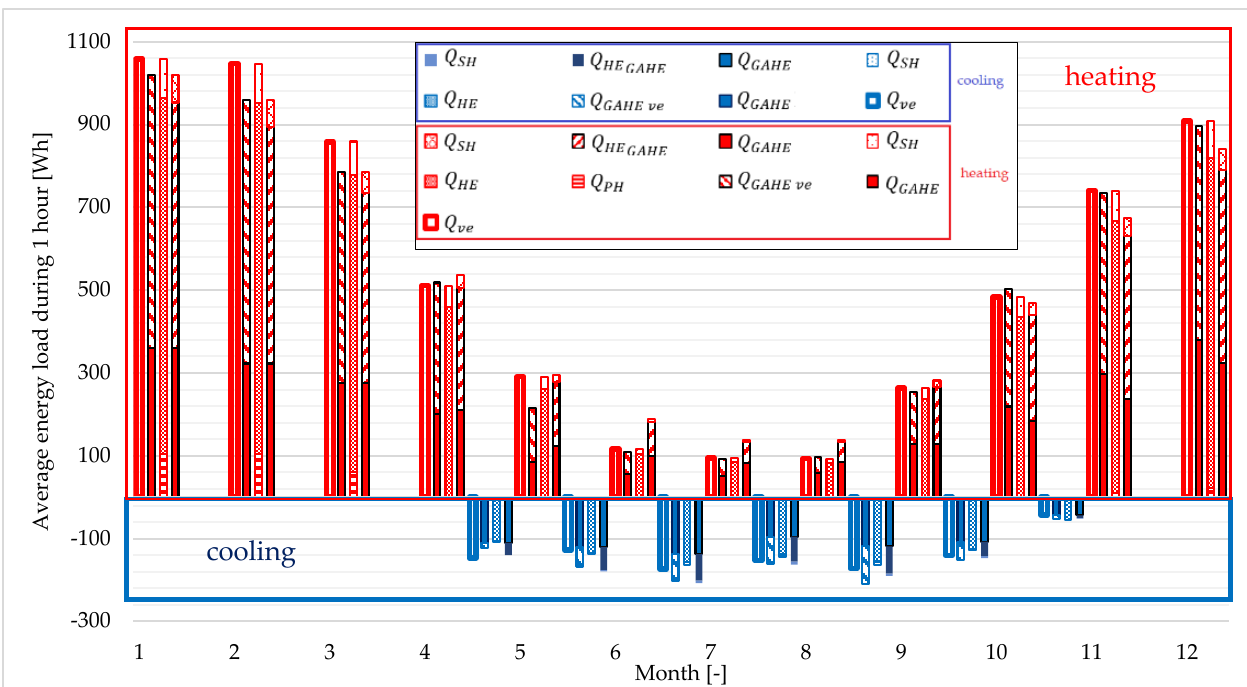
Figure 5. Average hourly energy load [Wh] in the ventilation system. In each month, variants 1, 2, 3, and 4 are represented by the respective bars in each group of four bars.